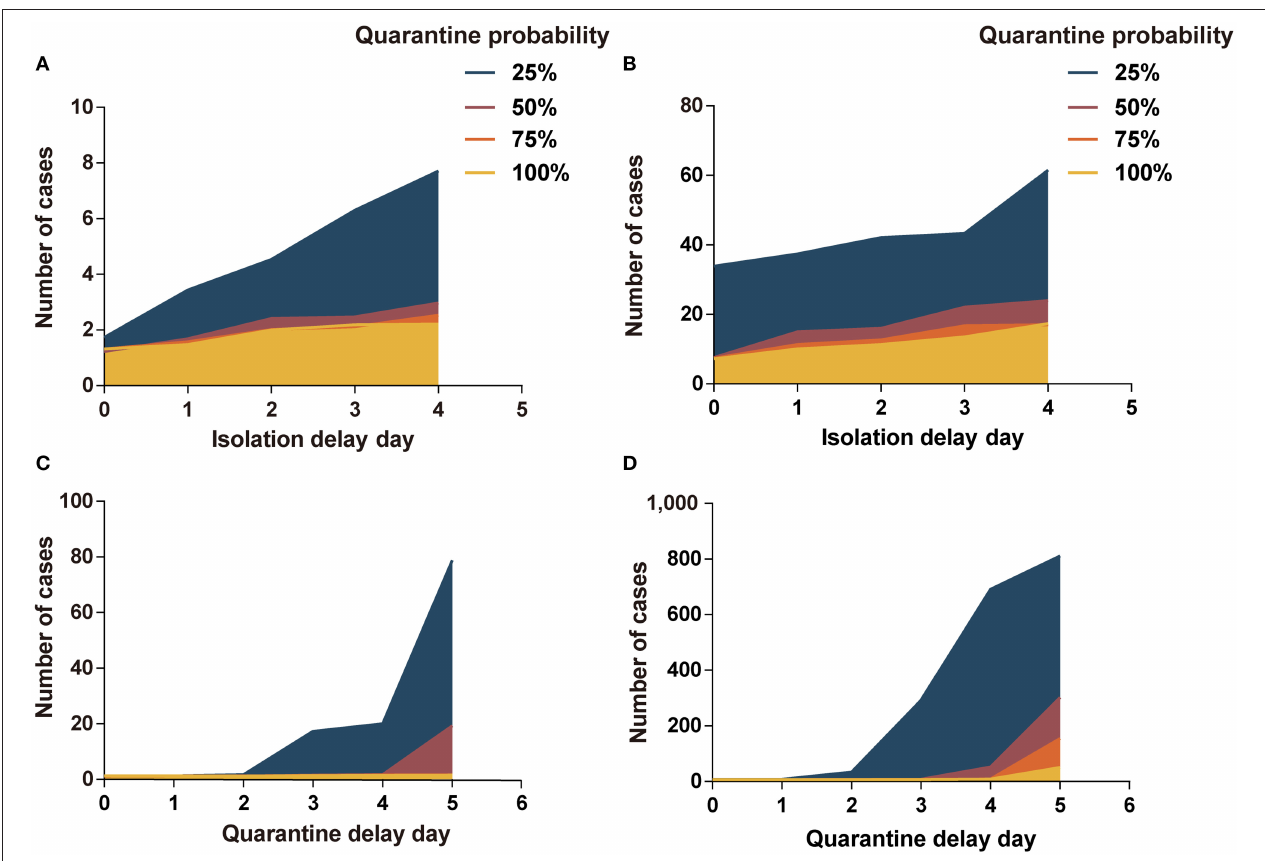
FIGURE 2 | Impact of isolation-and-quarantine parameters on interventions effectiveness. (A) The impact of isolation delay time and quarantine probability in scenario I; (B) the impact of isolation delay time and quarantine probability in scenario II; (C) the impact of quarantine delay time and quarantine probability in scenario I; (D) the impact of quarantine delay time and quarantine probability in scenario II. Program A: personal protection and